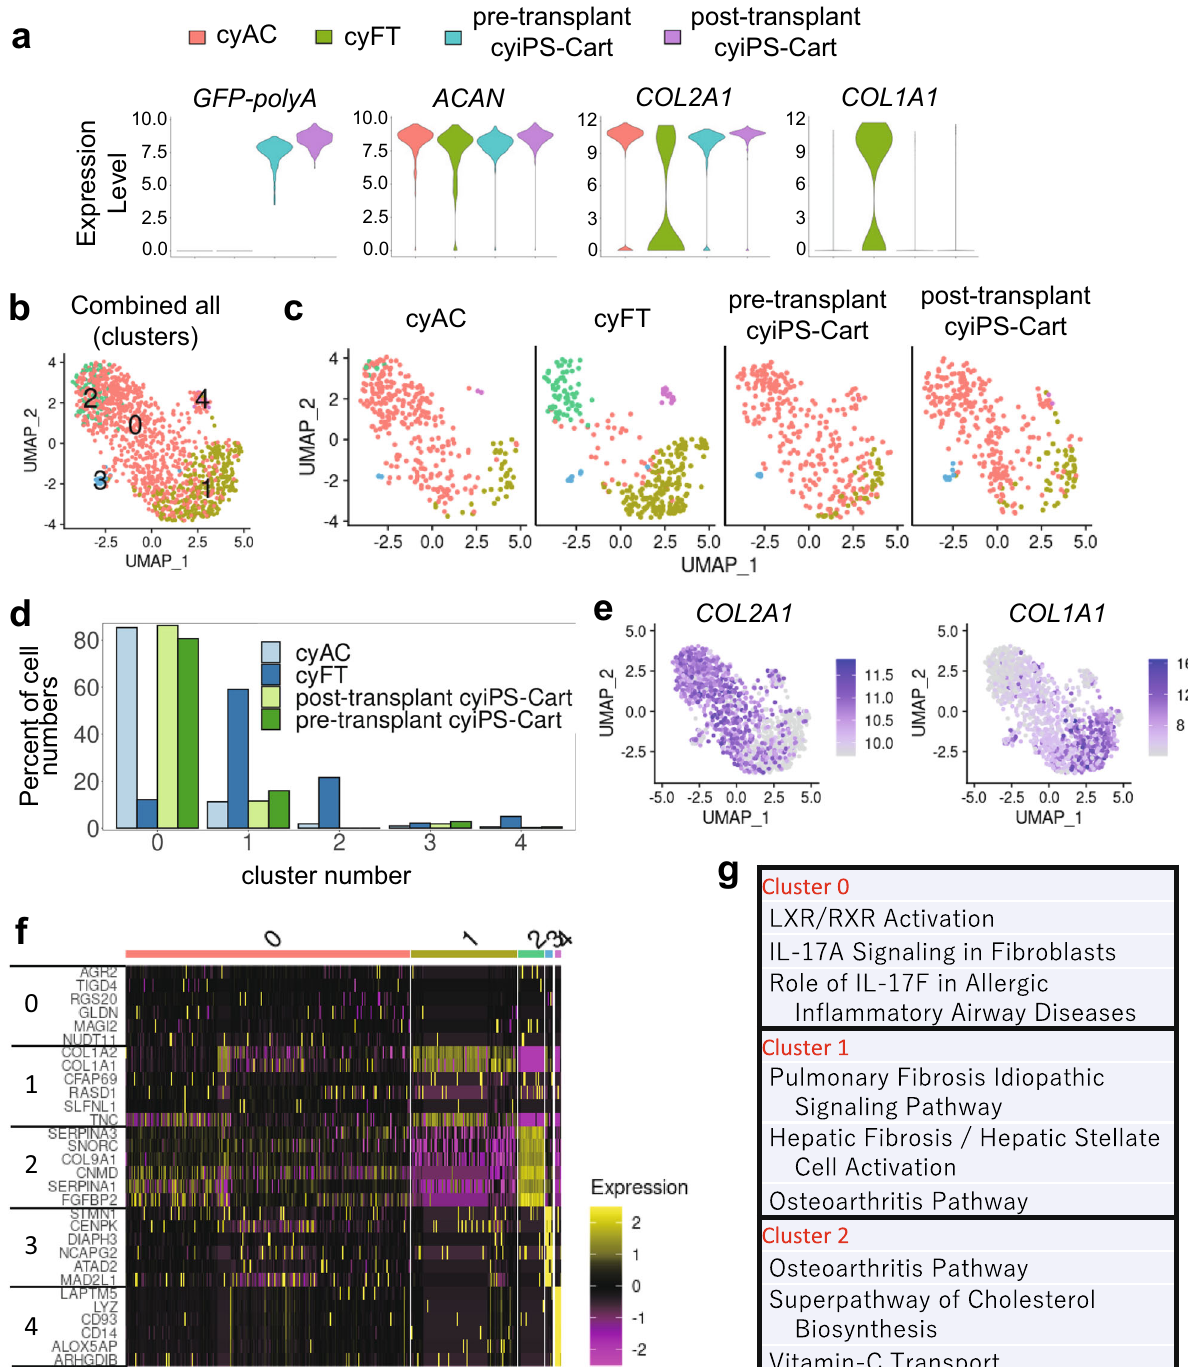
Fig. 6 | scRNA-seq analysis of cyAC, cyFT, pre-transplant cyiPS-Cart, and post- transplant cyiPS-Cart. a The VlnPlot (Seurat) shows the distribution of single- cell gene expression in each sample. The y-axis of each panel represents the expression levels of the indicated genes. b After reducing the cell number for each sample to 320, the data from the samples were integrated. The cells were then clustered with a parameter resolution of 0.2 and projected onto the UMAP plots. c UMAP plot in ( b ) separated by samples. d The ratio of the